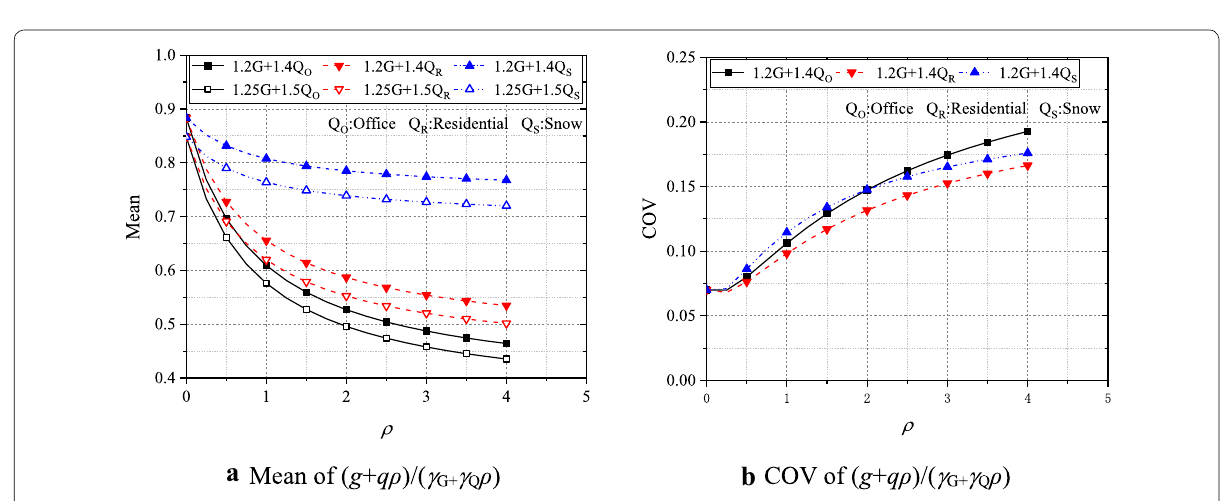
Fig. 7 Trend lines of the load effect term in the China analysis